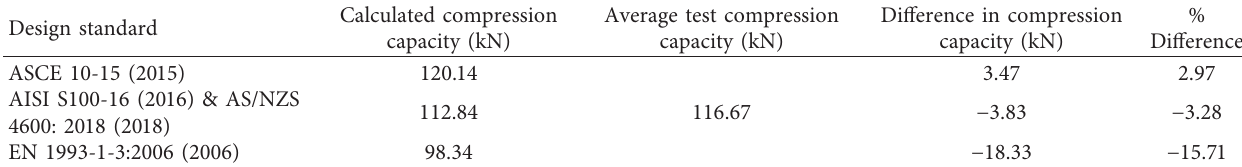
Table 2: Results of experimental investigation, column capacity in torsional-flexural buckling mode.